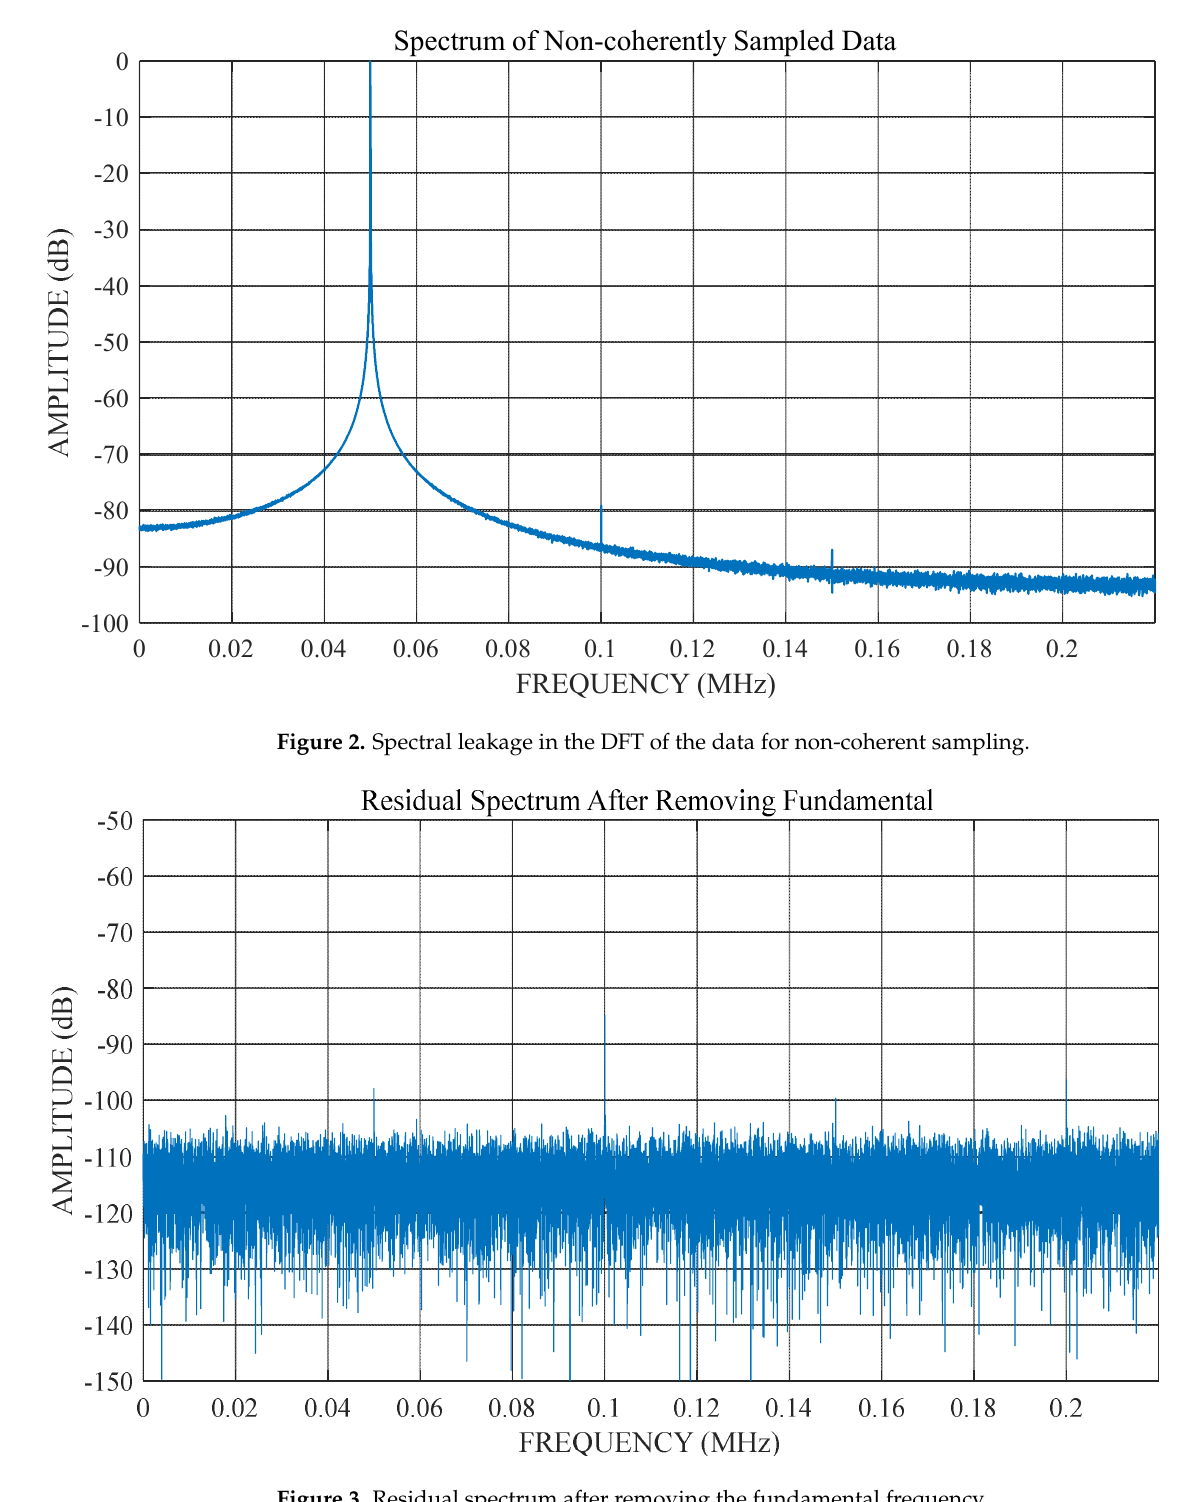
Figure 3. Residual spectrum after removing the fundamental frequency.